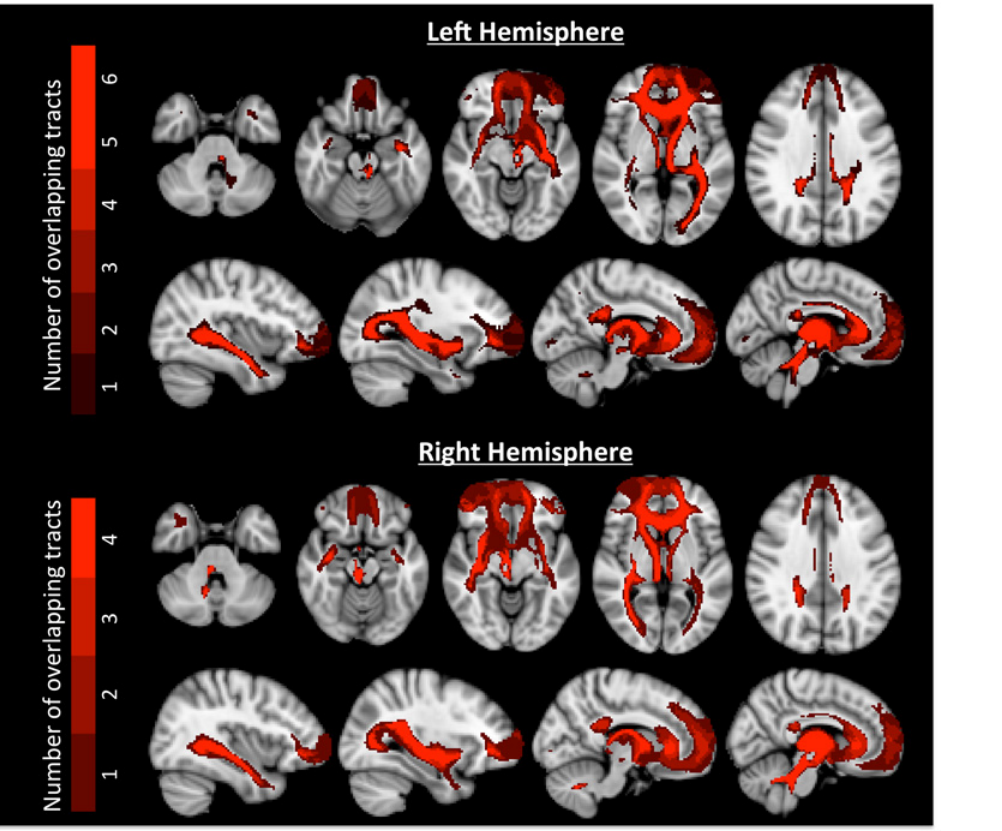
Fig 5. Figure showing the number of clusters that are connected to fiber tracts for the left K = 6 solution (top) and the right K = 4 solution (bottom). Color bars are shown on the left, with darker red indicating lower overlap and brighter red indicating greater overlap. Most cluster tracts had some degree of overlap with other cluster